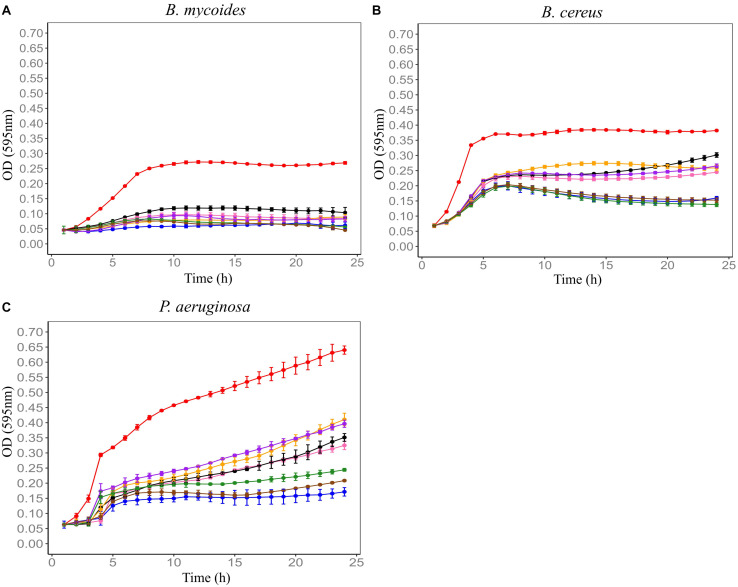
Influence of exposing Farm 4 soil conditioned medium (F4SCM) to different pH conditions on its antimicrobial activity against B. mycoides ATCC 6462 (A), B. cereus NZRM 5 (B), and P. aeruginosa ATCC 25668 (C). Bacteria were grown in the presence of butterfield’s diluent (red), F4SCM (blue), F4SCM exposed to pH2 (orange), F4SCM exposed to pH4 (purple), F4SCM exposed to pH6 (green), F4SCM exposed to pH8 (brown), F4SCM exposed to pH10 (pink), F4SCM exposed to pH12 (black). Each curve represents the mean growth rate ± SD (n = 3). Significant loss of activity was observed at high acidic (pH 2 and 4) and basic pH values (pH 10 and 12) against all three indicator microorganisms (p < 0.05 vs. untreated control/F4SCM).